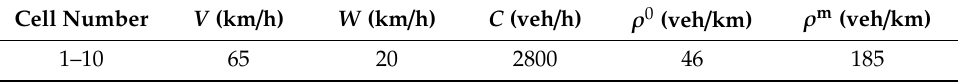
Figure 3. Illustration of the Jingtong freeway segment for the methodology application. Table 2. Cell-specific parameters of vehicles’ operational characteristics.